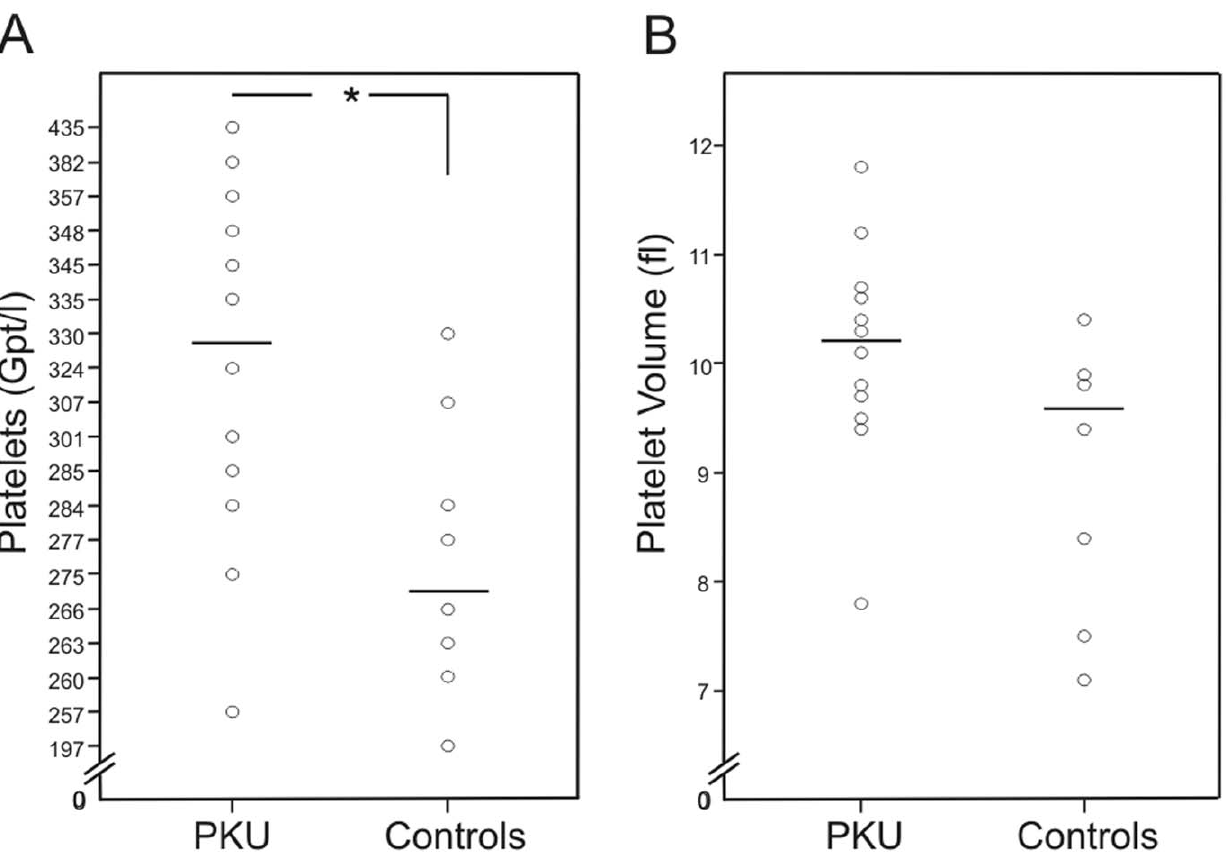
Figure 1. Platelet count and platelet volume. Data of patients with phenylketonuria (PKU) (n=12) and healthy controls (n=8). A platelet count (* p , 0.05) and B platelet volume. The stripe marks the median.